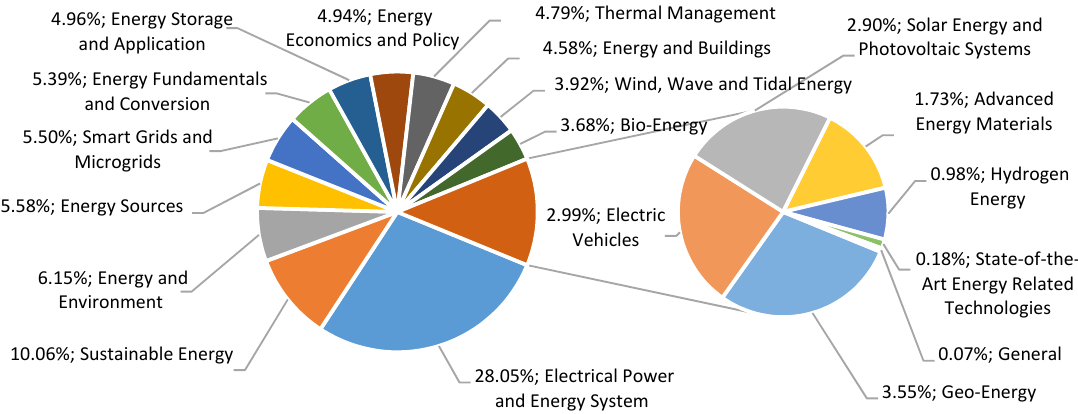
Figure 4 . Distribution of manuscripts by section.